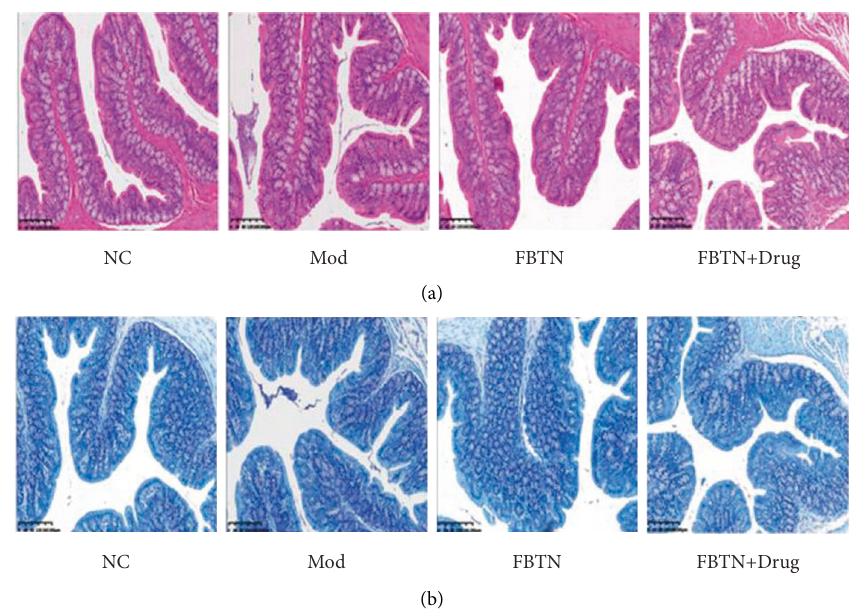
Figure 1: Abdominal massage attenuated the intestinal damages and infiltration of MC. (a) Morphological changes of small intestinal mucosa were detected by HE in normal (NC), IBS (mod), abdominal massage (FBTN), and ketotifen treatment groups (FBTN +drug) (scale bar 50 μ m). (b) Mast cells were detected by toluidine blue staining in normal, IBS, abdominal massage, and ketotifen treatment groups (scale bar 50 μ m).